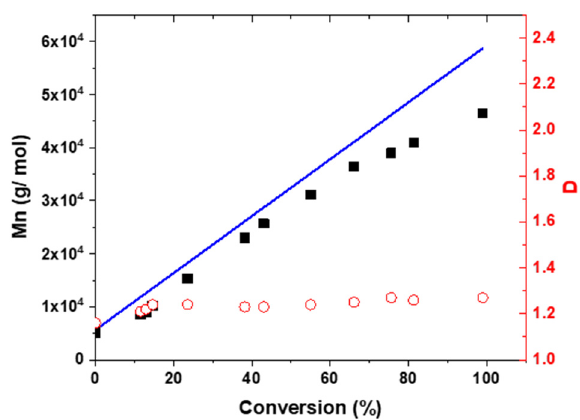
Figure 1. Kinetic data (Conversion %: Black squares, Semi-log: Red squares) obtained for the RAFT dispersion polymerization of HFBMA at 10% w / w solids in ethanol at 70 °C using a PDMA 39 macro- CTA at a macro-CTA/AIBN molar ratio of 5/1. The targeted diblock composition was PDMA 39 – PHFBMA 200 .